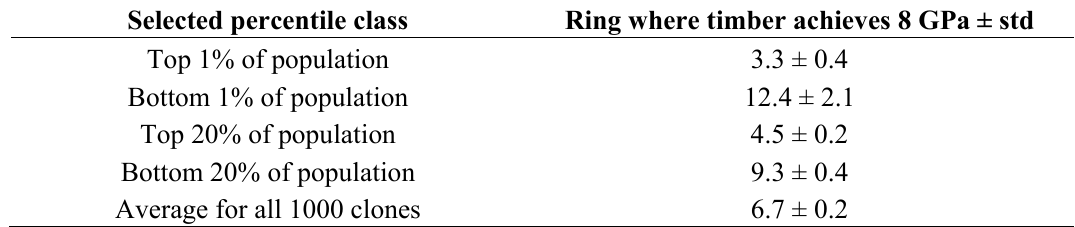
Table 3. Modeling of clearwood stiffness of Pinus radiata clones average growth